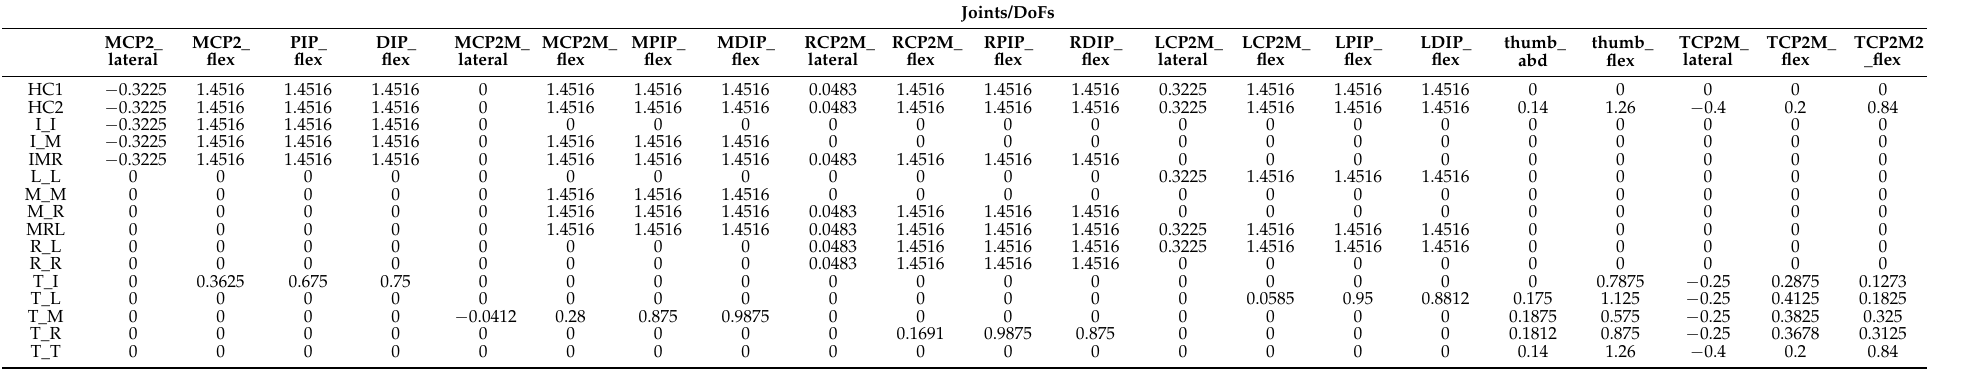
Table 4. Advancement vectors for each of the movement classes. A vector contains the degrees of rotation for each of the joints considered in the movement. A special case is the hand close motion, which required one of two possible vectors, depending on the time position of the motion. The labels of the joints correspond to the Opensim model